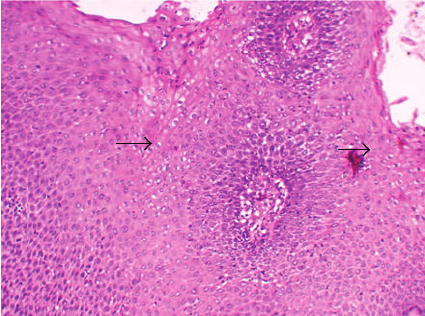
Figure 8: Photomicrograph of the lesion showing koilocytes (arrows) in the epithelium. Koilocytes display a hyperchromatic shrunken nucleus with clear cytoplasm (perinuclear halo) (H&E,